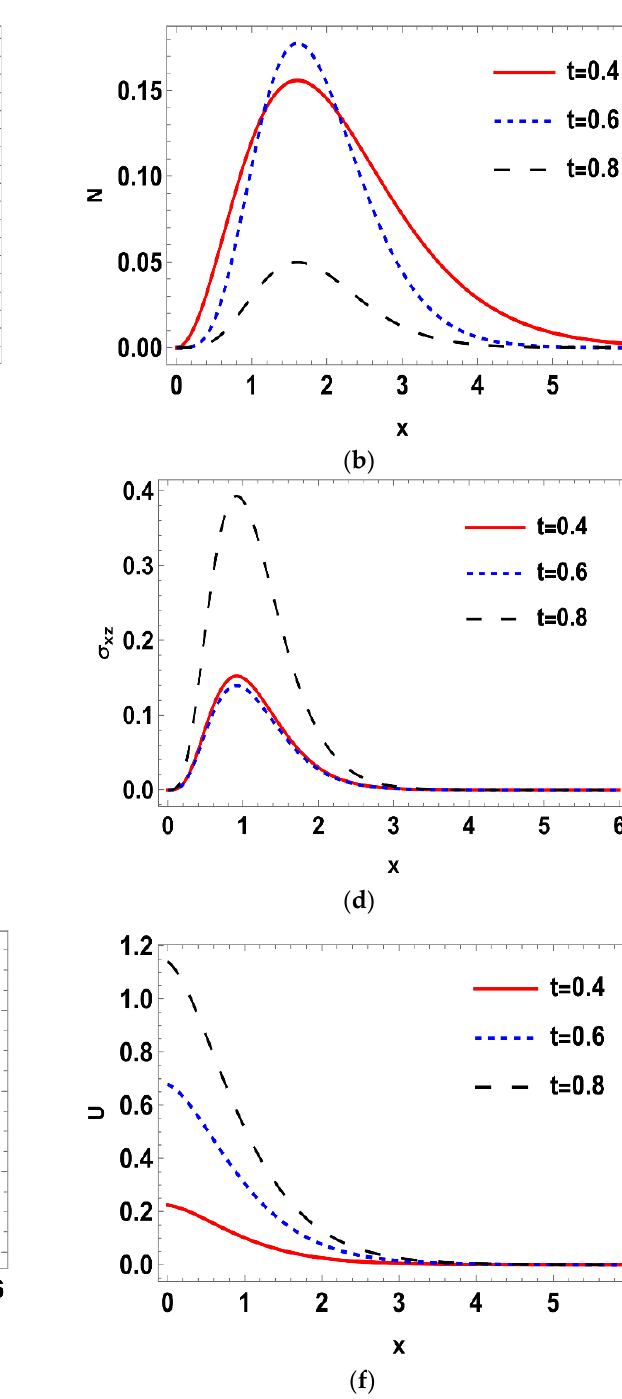
Figure 2. ( a – f ) The deterministic and stochastic distributions of temperature, normal stress, carrier density, displacement and heat conduction distributions along the distance at 0.4 t = in relation to generalized photo-thermoelasticity theory, when 5 a = .